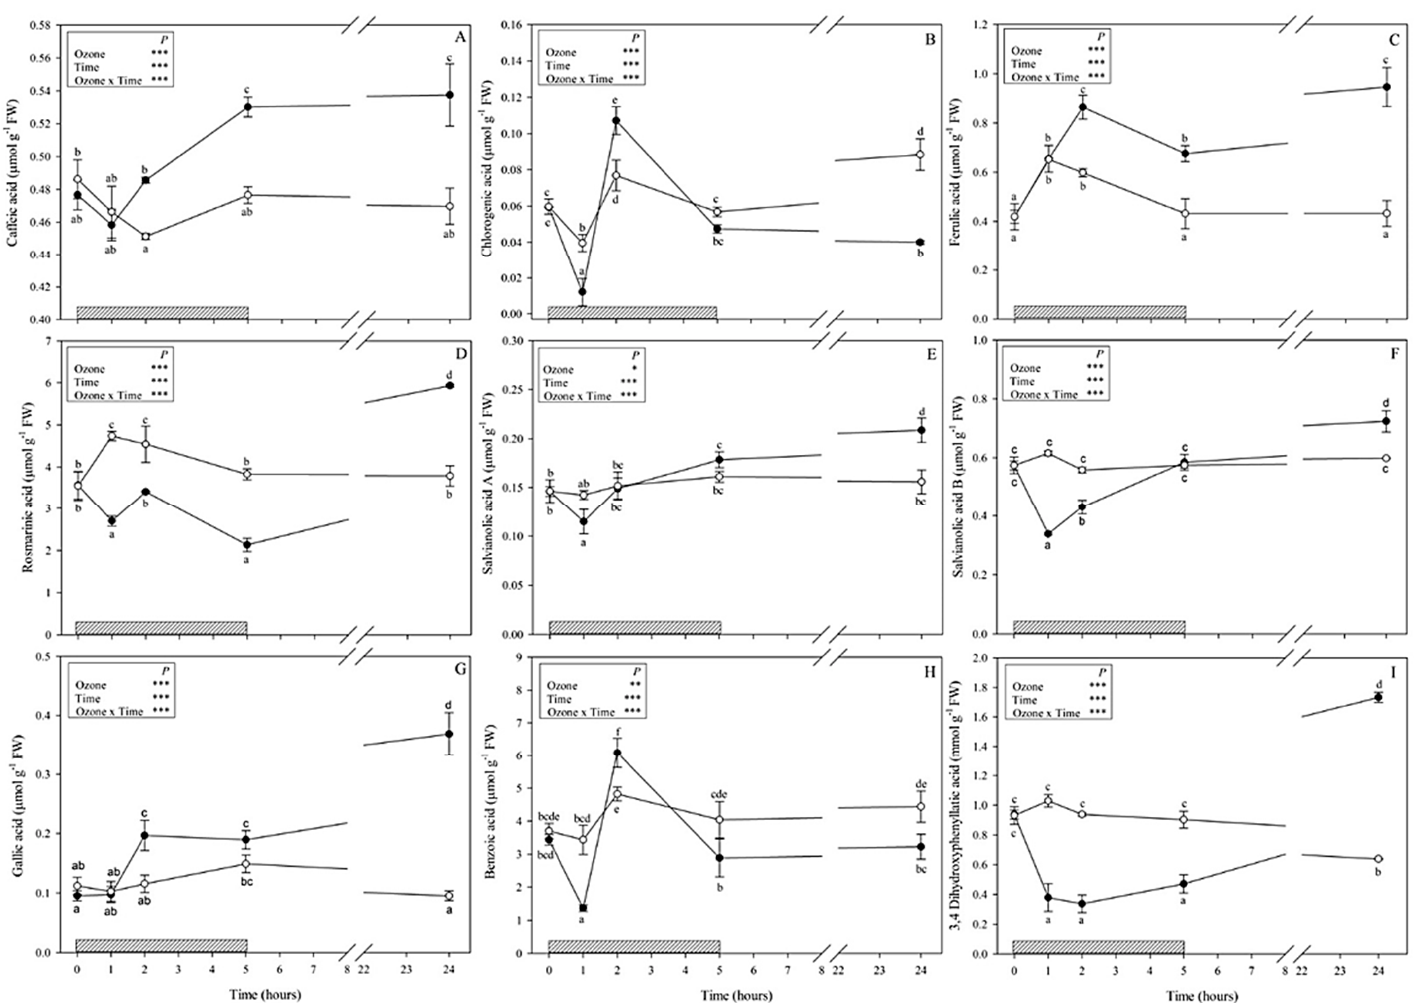
Figure 2. Content of phenolic acids (caffeic acid ( A ), chlorogenic acid ( B ), ferulic acid ( C ), rosmarinic acid ( D ), salvianolic acid A ( E )and salvianolic acid B ( F ), gallic acid ( G ), benzoic acid ( H ), 3,4 dihydroxyphenyllatic acid ( I )) (µmol g − 1 FW) in leaves of Salvia officinalis exposed to ozone (120 ppb, 5 h; closed circle) or maintained under filtered air (controls; open circle). Measurements were carried out at 0, 1, 2, 5, and 24 h from the beginning of exposure. Data are shown as mean ± standard deviation ( n = 3). p -values show the results of a full factorial two-way analysis of variance (ANOVA) with O 3 and time as variability factors (*** p ≤ 0.001; ** p ≤ 0.01; * p ≤ 0.05; ns: p > 0.05). For each compound ( A – I ), different lowercase letters (a–e) indicate significant differences among means, according to the Tukey’s HSD post- hoc test ( p ≤ 0.05). FW = fresh weight.